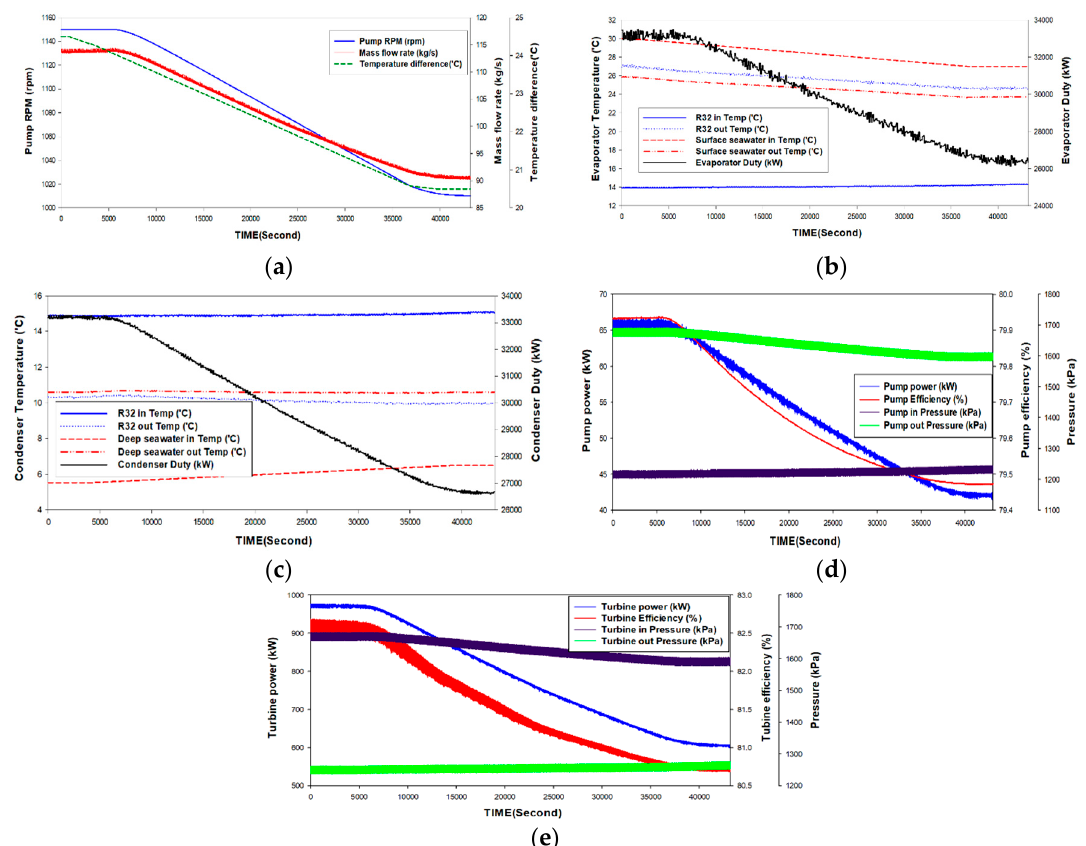
Figure 8. Dynamic variations in turbine and heat exchange with PID controller according to the surface and deep water temperature differences: ( a ) refrigerant pump RPM and flow rate; ( b ) temperatures and heat capacity of the evaporator; ( c ) temperatures and heat capacity of the condenser; ( d ) power and efficiency of the refrigerant pump; ( e ) turbine output and efficiency.